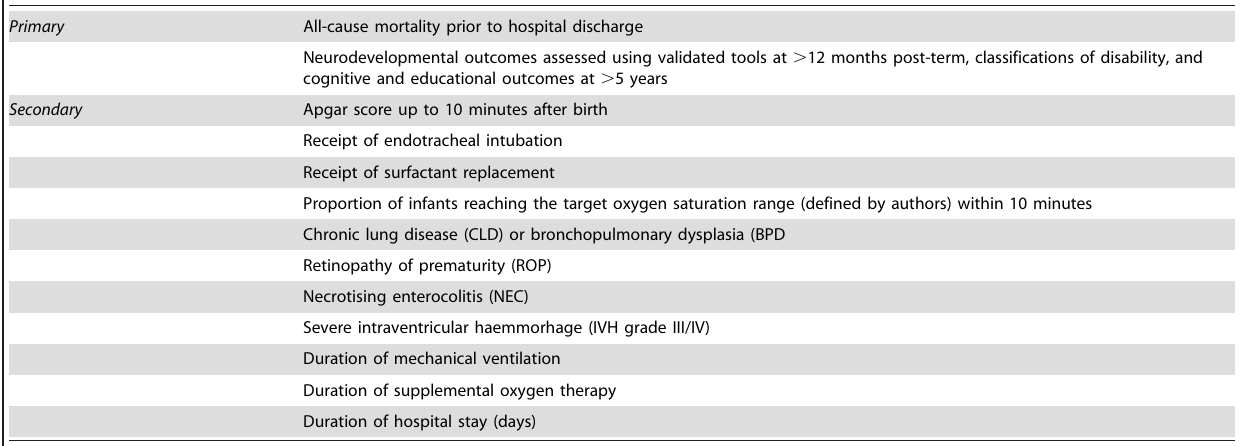
Table 2. Outcomes.